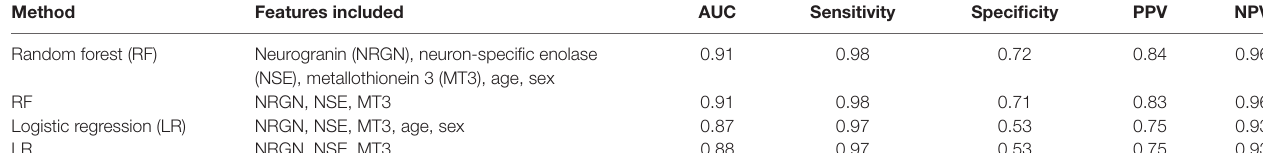
TaBle 3 | ROC curve analysis for performance of top panels in discriminating mild TBI from controls, listed by statistical method and features included.